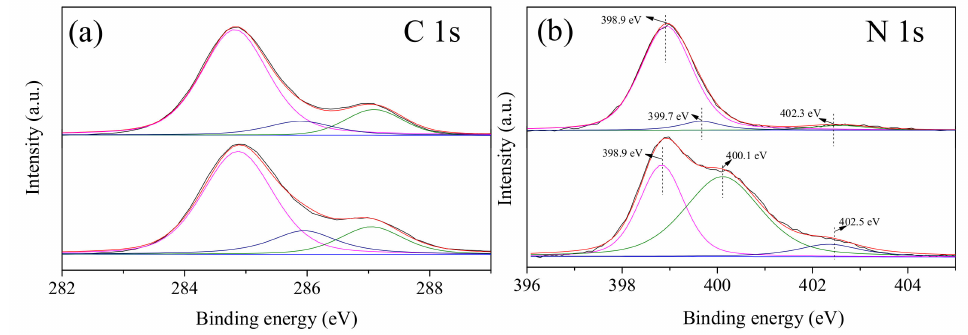
Figure 6. XPS patterns of CTF and 1%PCN@CTF: ( a ) C 1s and ( b ) N